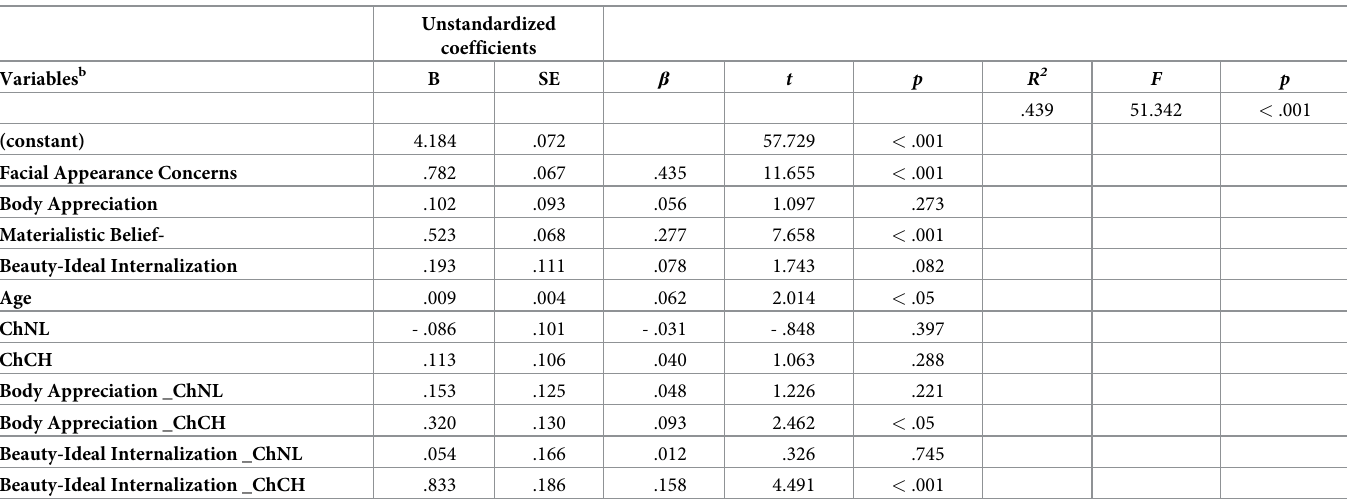
Table 7. Regression estimates of model 2 a